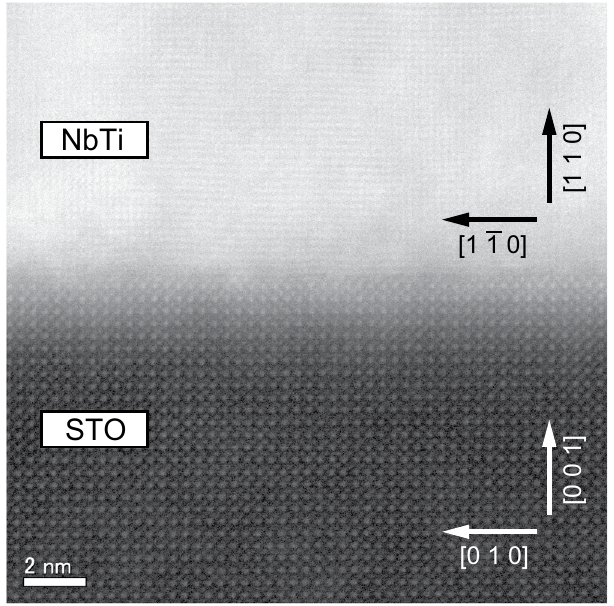
Figure 2. Cross-sectional STEM image of an interface between 400-nm-thick NbTi alloy thin film and STO substrate. The atomic image representing crystallized NbTi was observed at the